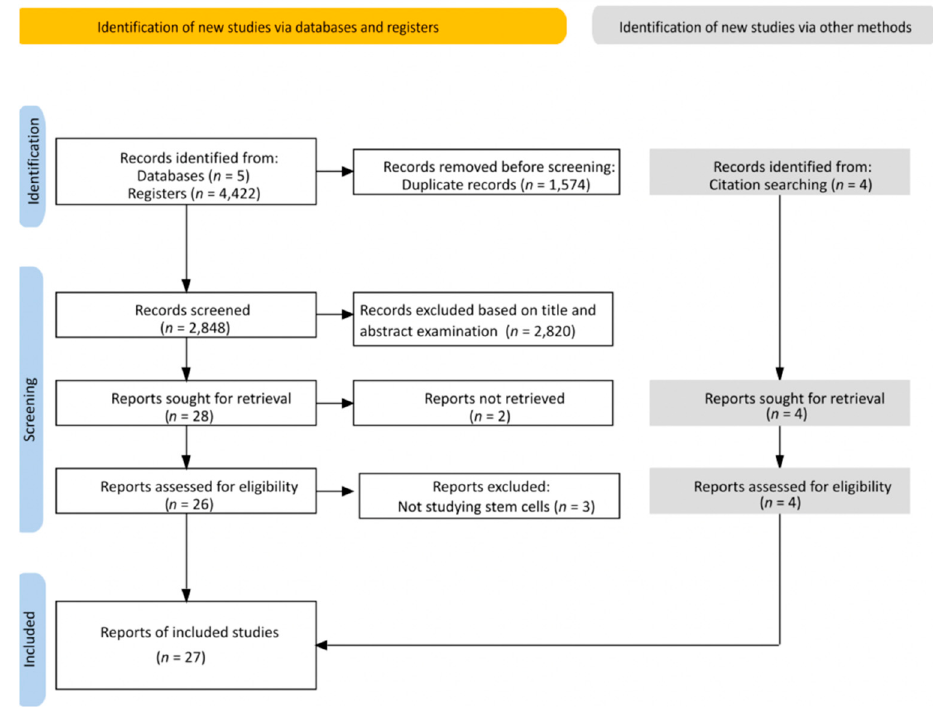
Figure 1. PRISMA flow diagram.